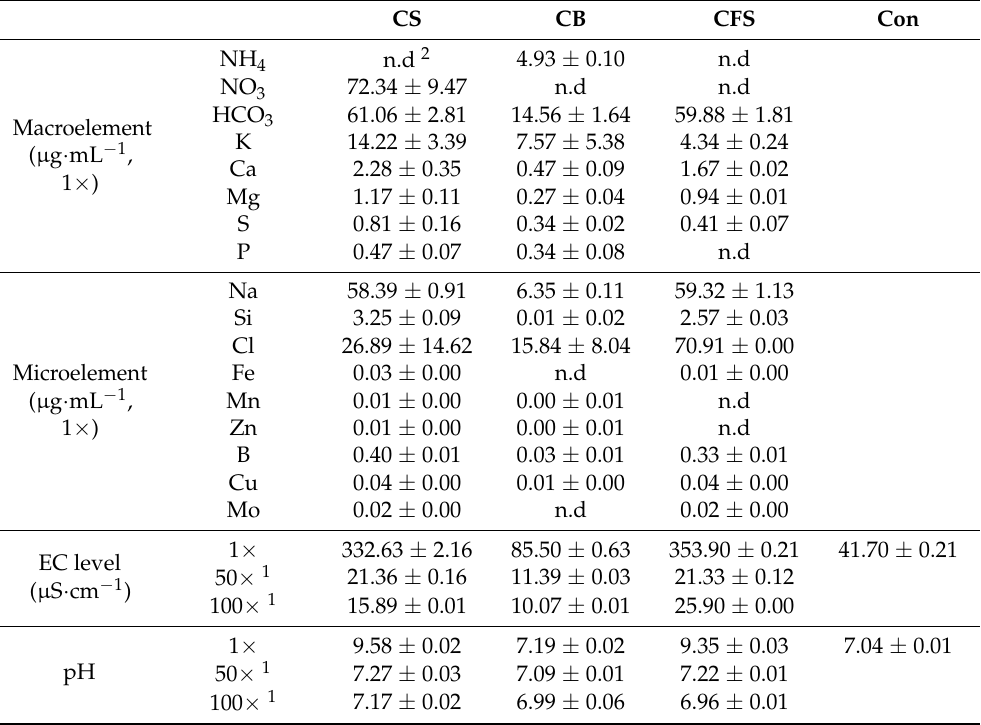
Table 2. Mineral contents and physicochemical characteristics of Chlorella